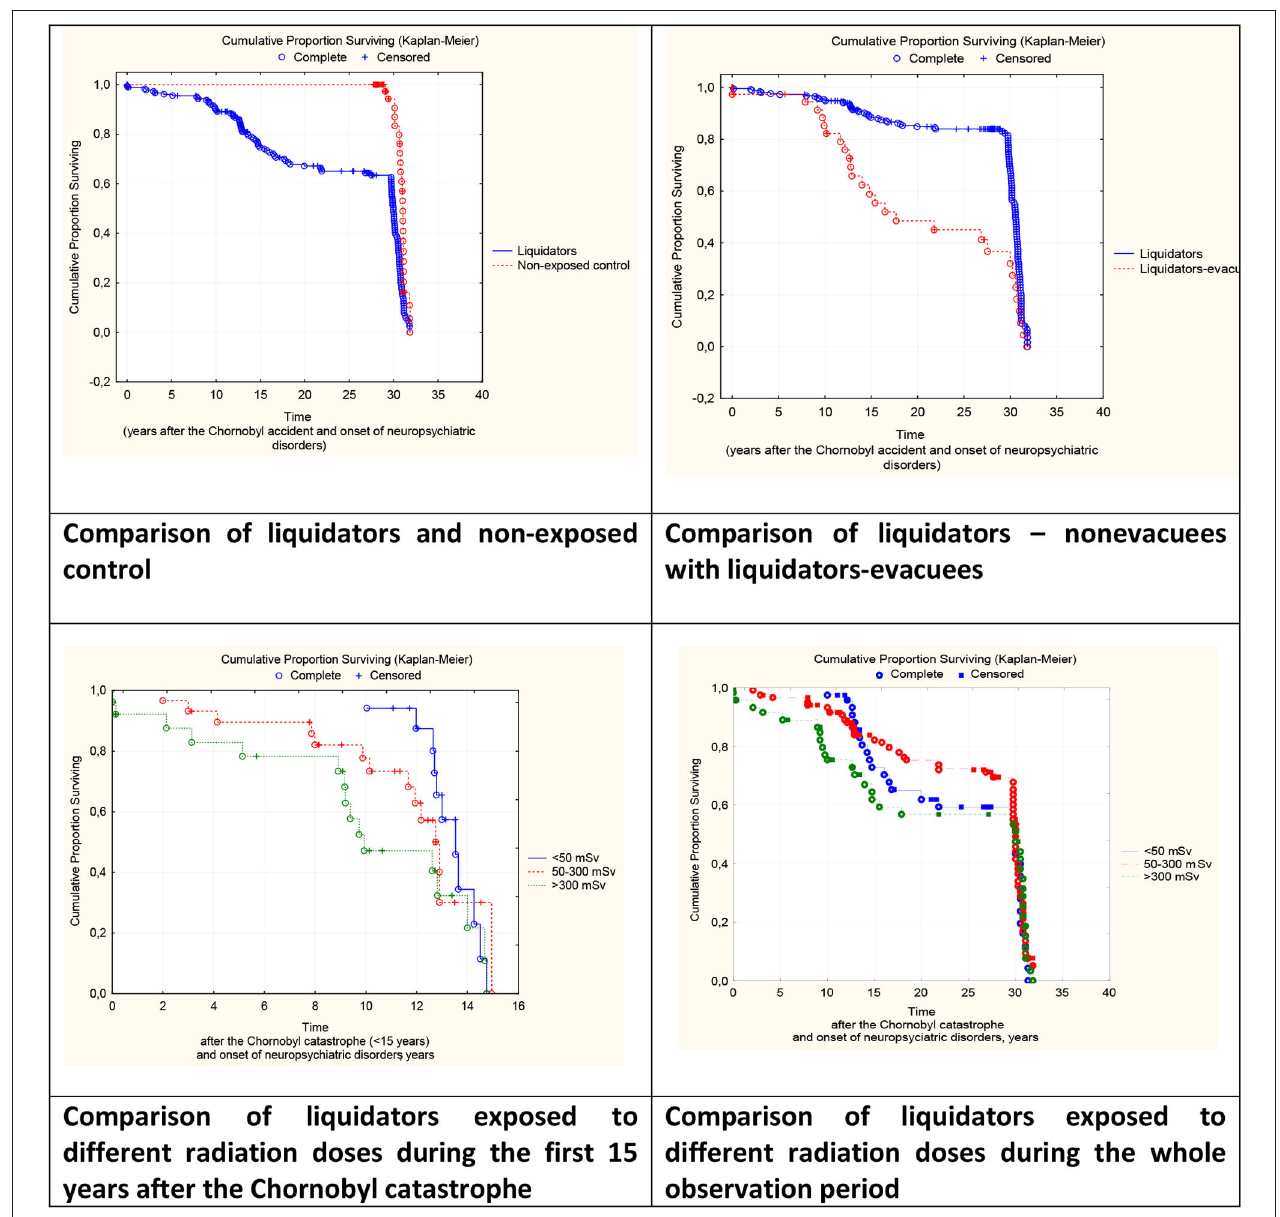
FIGURE 1 | Survival curves (Kaplan & Meier) for neuropsychiatric pathology onset after the Chornobyl